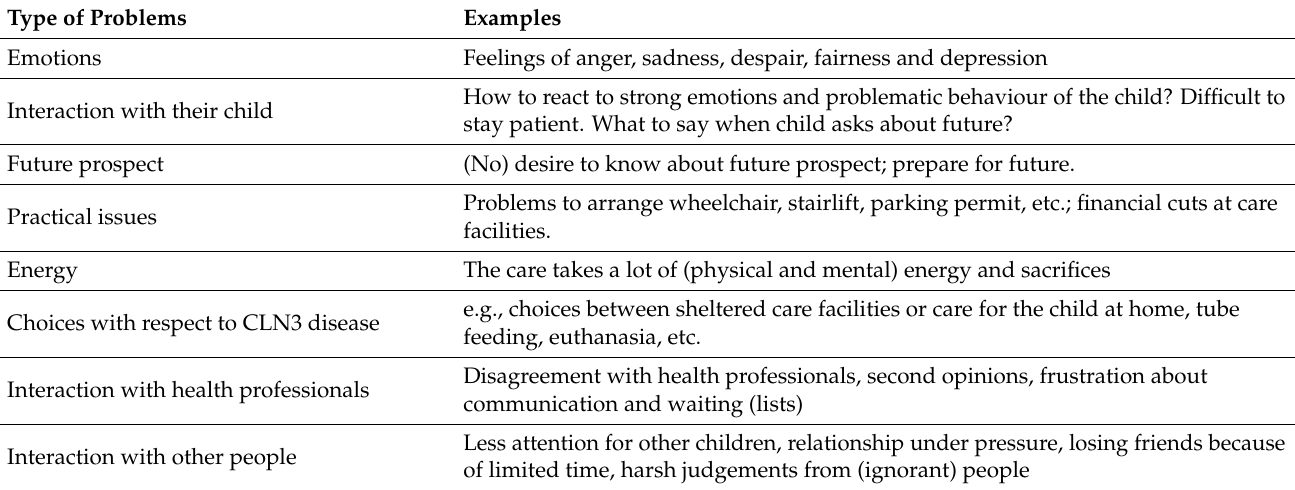
Table 4. Observed problems of parents concerning CLN3